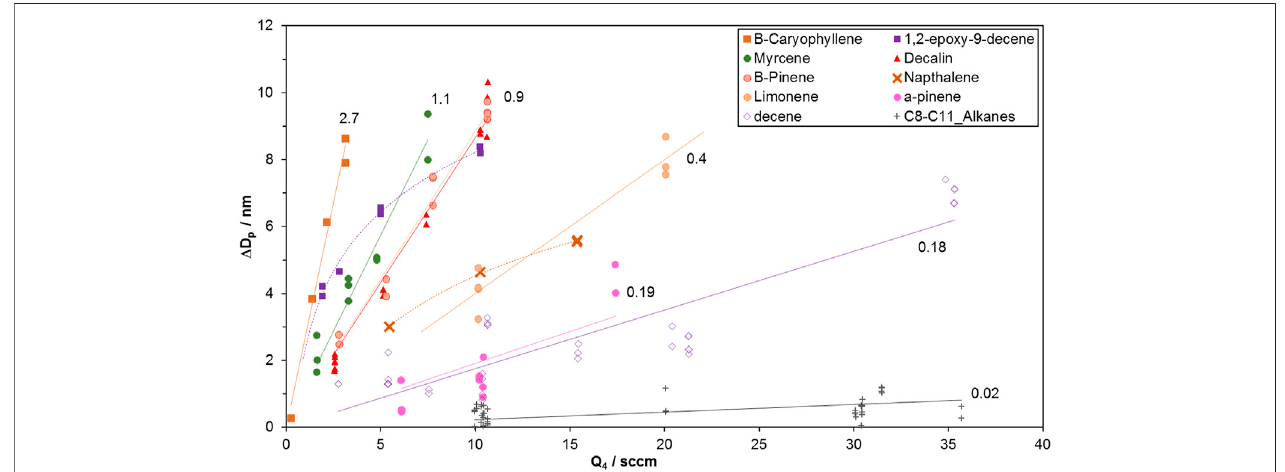
FIGURE 1 | Growth vs HONO-laden fl ow of clean air, Q 4 (HONO is present at ~10 ppmv in this fl ow). At Q 4 = 10 sccm, the initial HONO abundance in the fl ow reactor is 64 ppbv or 1.5 × 10 12 cm − 3 , taking into account the initial NO and NO 2 impurities, each at ~ 2%. Slopes (nm/sccm) are indicated next to the regressions lines (forced through zero.). Note the non-linear data for 1,2-epoxydec-9-ene and naphthalene where the curvature indicates larger yields at lower oxidation rates. The abundance of these species in the fl ow reactor may have been low: epoxydecene ’ s vapor pressure is unknown and is estimated to be low and naphthalene loss onto the delivery lines was an issue. At low precursor abundances, OH radicals can signi fi cantly react with HONO, potentially limiting the amount of SOA formed. The SOA yields for these two species were taken from the initial change in diameter, i.e. Δ D p /Q 4 at the lowest Q 4 value. β -caryophyllene and the C-12 species also have low vapor pressures. The data is clearly linear for β -caryophyllene which is not unexpected at the low HONO for these experiments (see Supplementary Material for more discussion).SOAformedfromtheC-12precursorswaslow(average Δ